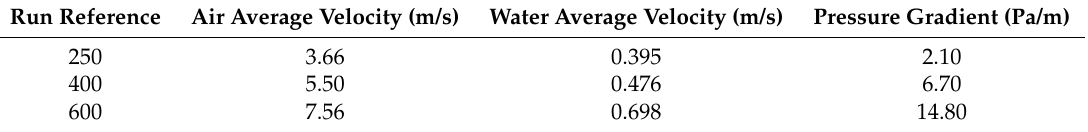
Table 1. Flow conditions and experimental data